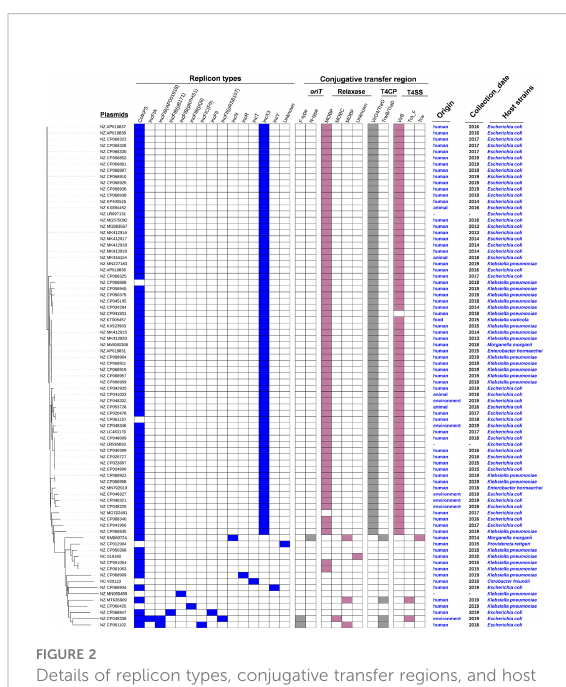
FIGURE 2 Details of replicon types, conjugative transfer regions, and host strains of the 81 bla OXA-181 -positive plasmids in Enterobacterales . The six categories of information present in this fi gure include the phylogenetic tree, replicon types, conjugative transfer regions ( oriT , relaxase, T4CP, and T4SS), origin, collection date, and host strains of 81 bla OXA-181 -positive plasmids.